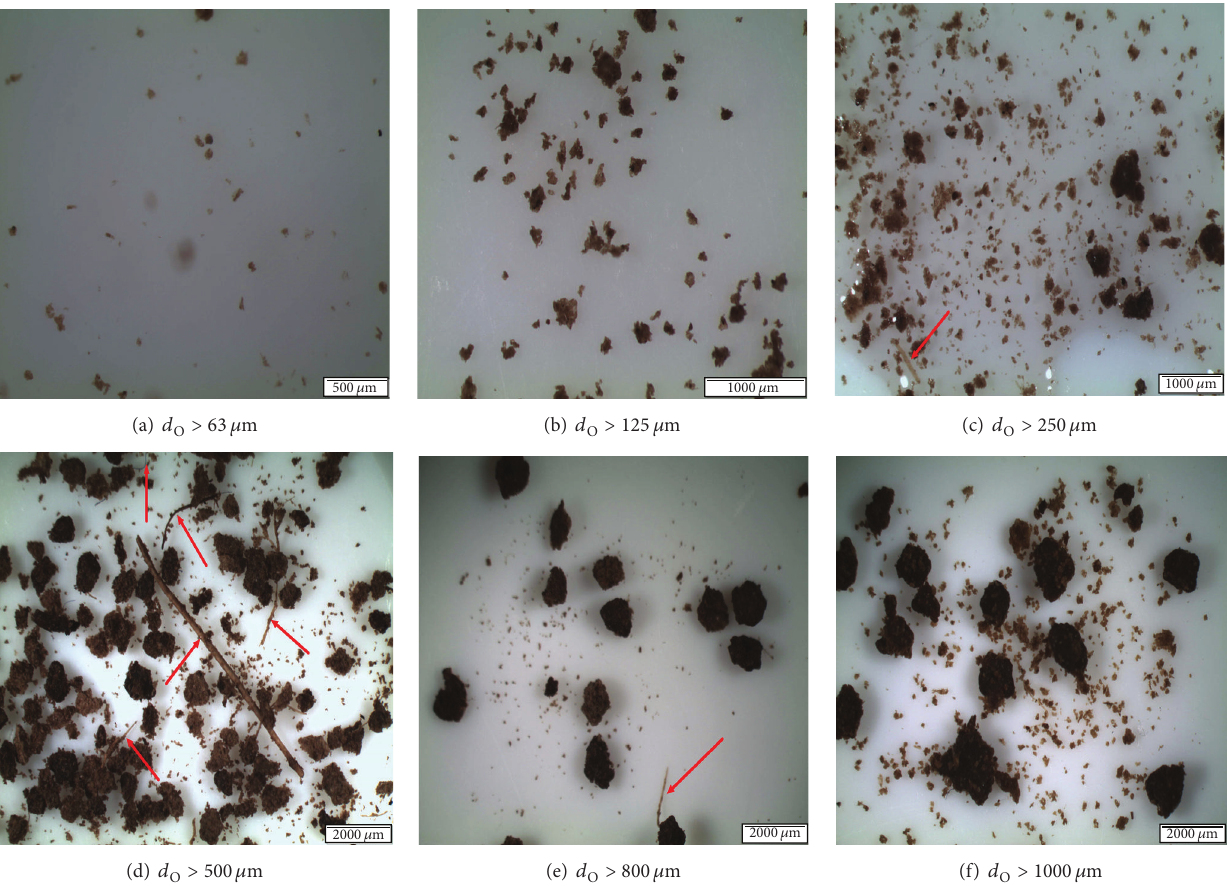
F 5: Presence of �bres among the oily POME particles observed form sieving at different opening size.